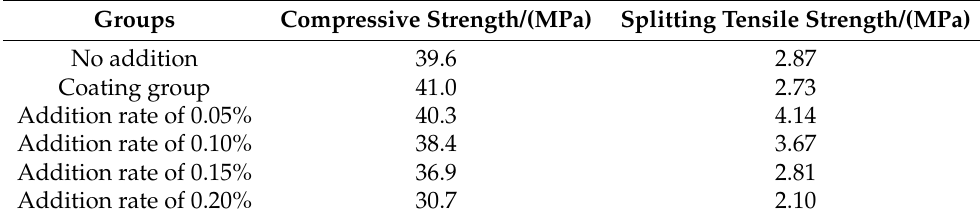
Table 8. Results of mechanical tests before the suspension. Groups Compressive Strength/(MPa) Splitting Tensile Strength/(MPa) No addition 39.6 2.87 Coating group 41.0 2.73 Addition rate of 0.05% 40.3 4.14 Addition rate of 0.10% 38.4 3.67 Addition rate of 0.15% 36.9 2.81 Addition rate of 0.20% 30.7